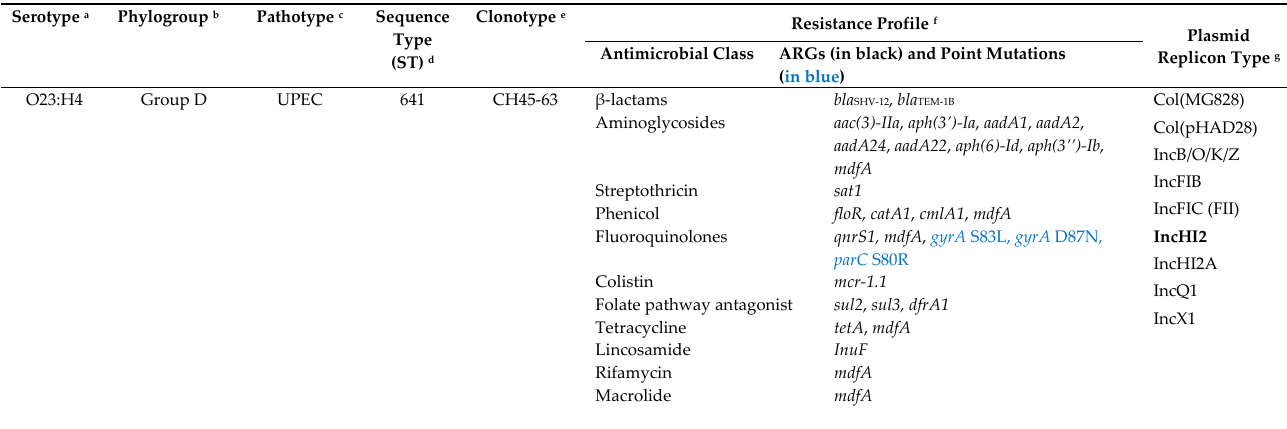
Table 4. Features, molecular typing, resistance profile and plasmid replicon types carried in UPEC EC13049 isolate from Egypt. Serotype